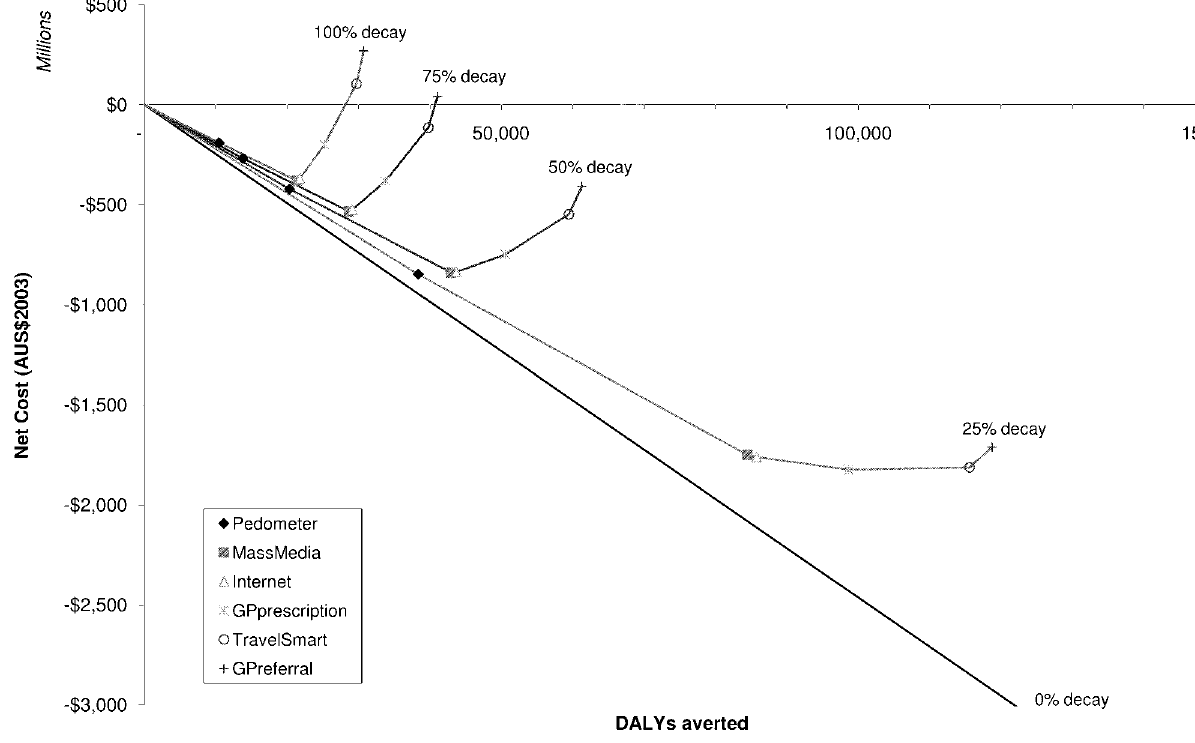
Figure 3. Sensitivity of the intervention pathway to the rate of decay in intervention health effects.